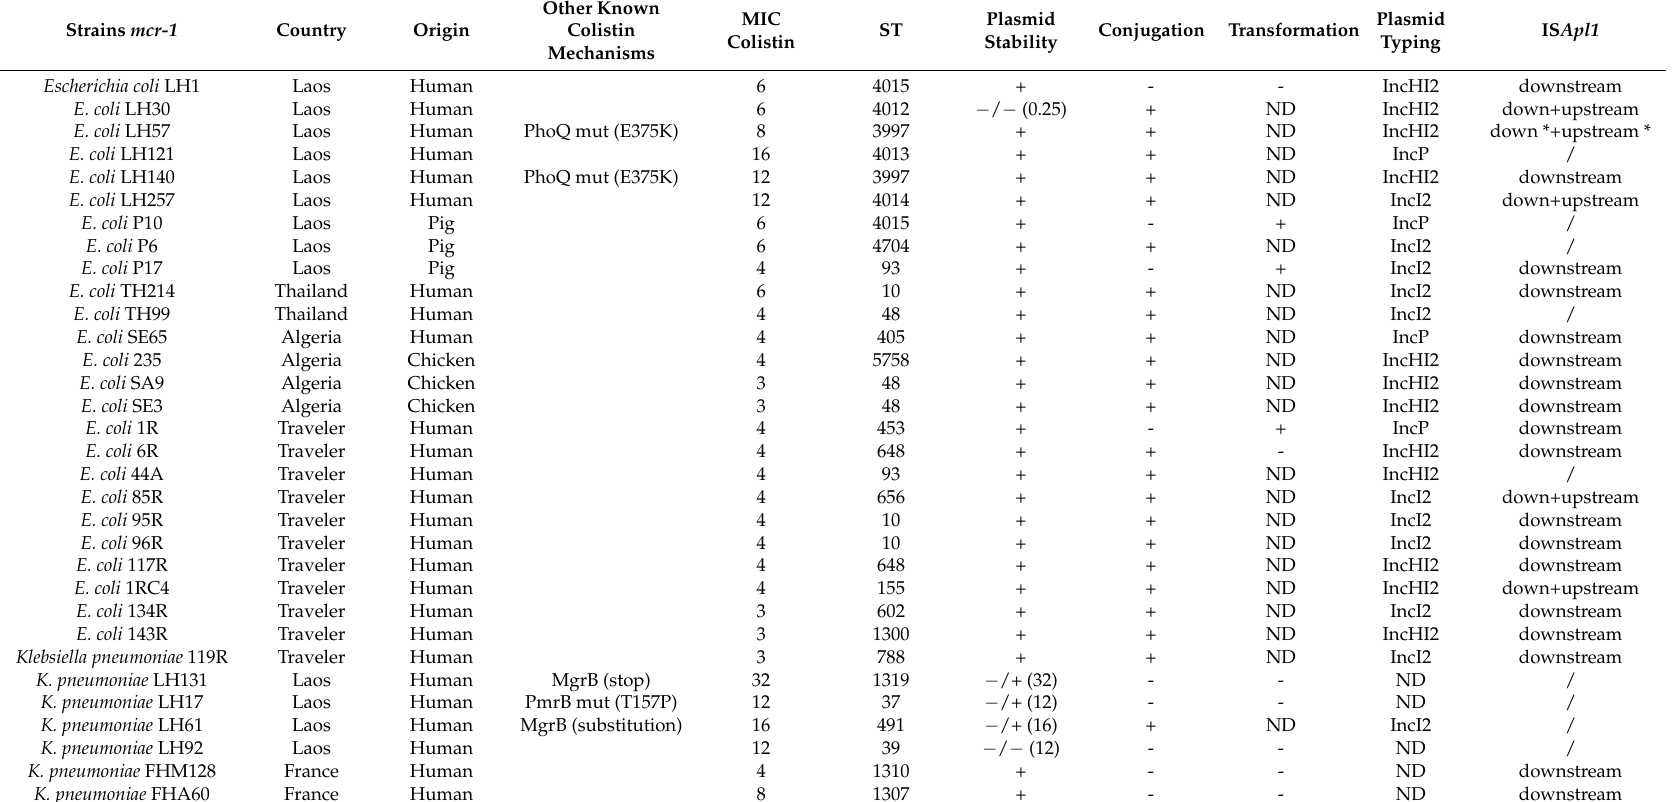
Table 1. Origins and genotypic characteristics of mcr-1 strains analysed in this